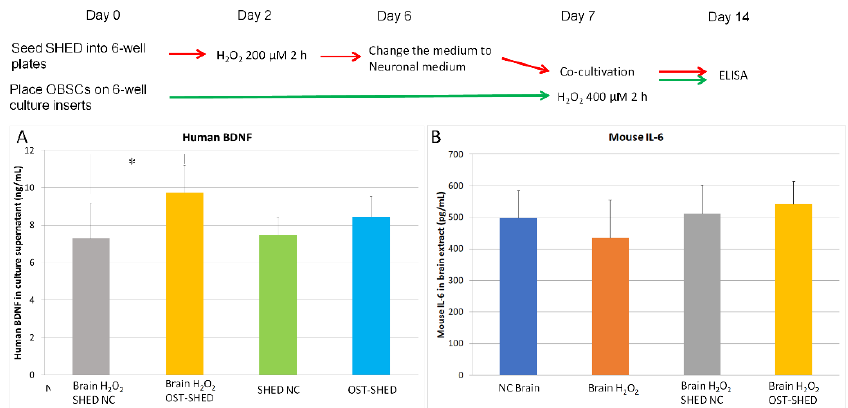
Figure 6. Production of human BDNF in SHED and mouse IL-6 in OBSCs. The culture supernatant was collected at the end of cultivation (day 14). ( A ), Levels of SHED-produced human BDNF detected by ELISA; ( B ), Levels of mouse brain tissue-produced IL-6 measured by ELISA. Data are presented as mean ± SD. * p < 0.05.